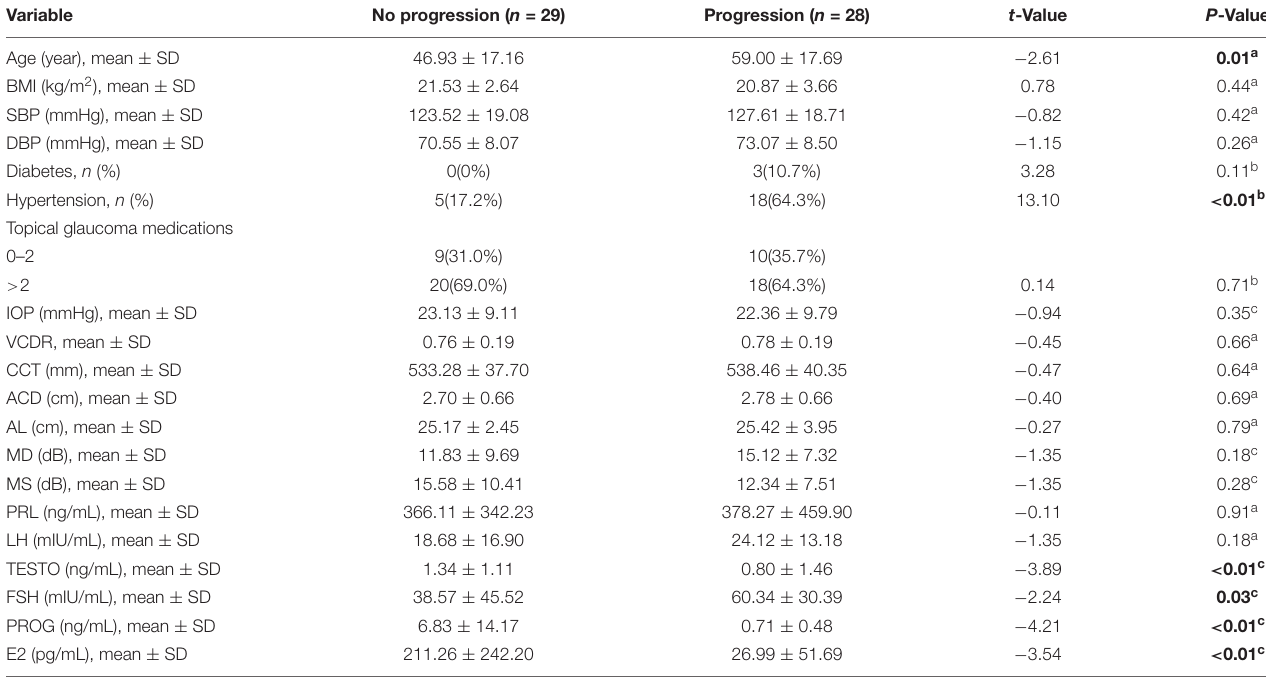
TABLE 4 | Comparison of characteristics of no progression group and progression group in POAG subjects. Variable No progression ( n =